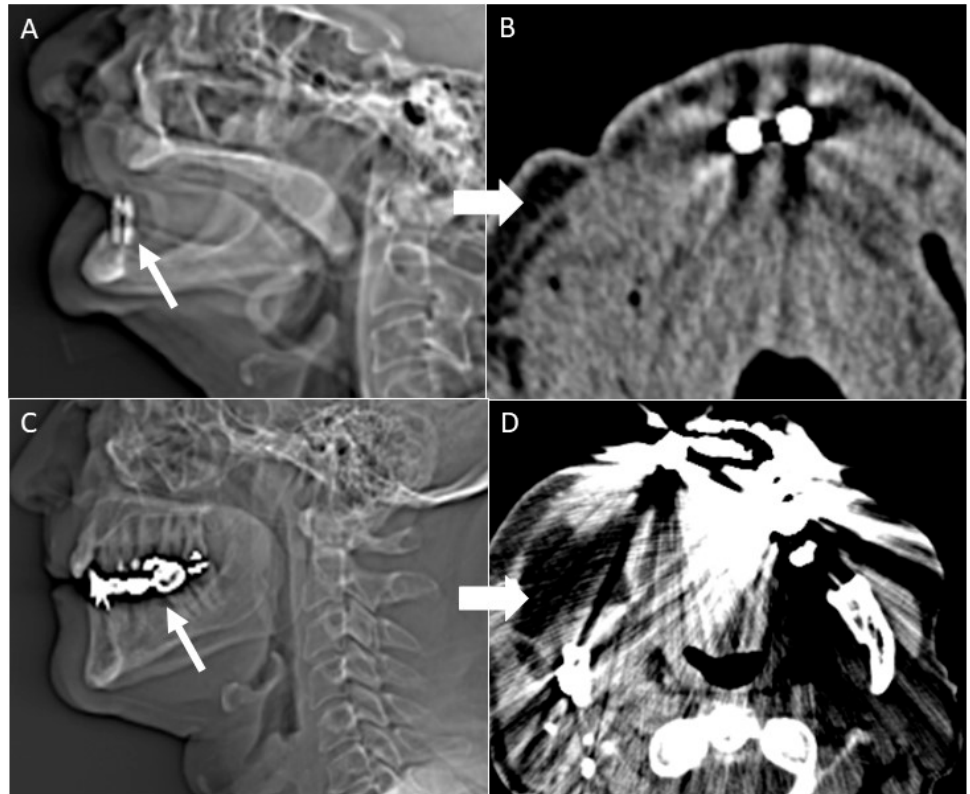
Figure 18. Dental metal artifacts on MSCT examinations. ( A , B ) Beam hardening artifacts occurring when the X-ray beam hits a metal with a low atomic number. ( A ) MSCT scout view shows two titanium implants located on the anterior lower jaw (arrow). ( B ) Axial image characterised by hypodense streaks gradually reducing from the area of interest towards the periphery. ( C , D ) Photon starvation artifacts occurring when the X-ray beam hits a metal with a high thickness or high atomic number. ( C ) MSCT scout view in which many silver amalgam crowns and multiple dental restoration therapies are found. ( D ) Axial image shows the typical artifacts with alternated hypo/hyperdense streaks opening as a fan from the metallic area.